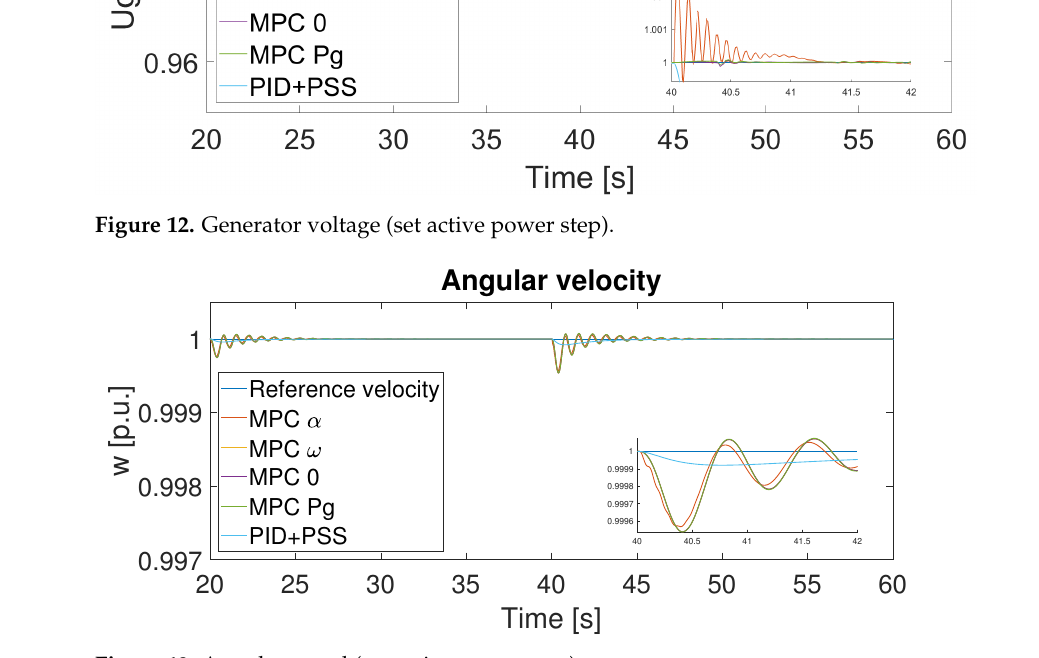
Figure 13. Angular speed (set active power step).